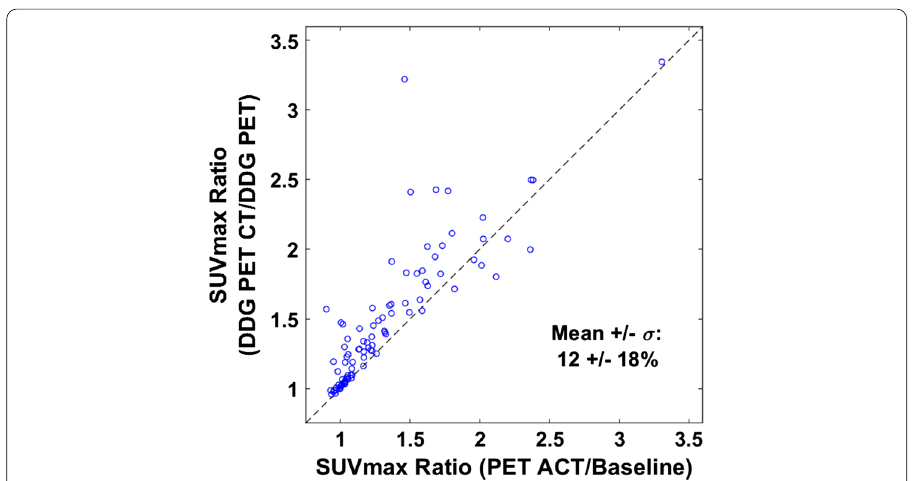
Fig. 4 Scatter plot of SUV max ratios: DDG-PET/CT relative to DDG-PET vs PET/ACT relative to baseline PET/ CT. The dashed line is the line of equivalence. The mean and standard deviation of the % increase in the DDG-PET/CT relative to DDG-PET ratio are